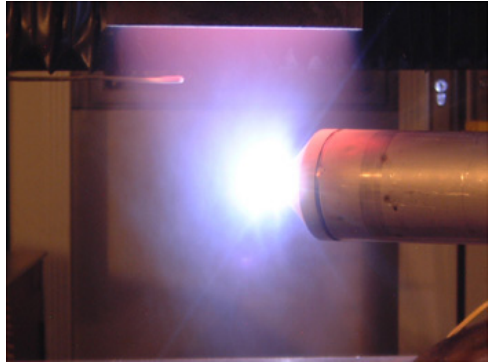
Figure 1. Stand-off LIBS probe head. Laser ablation energy and spectroscopic collection occurs through fiber